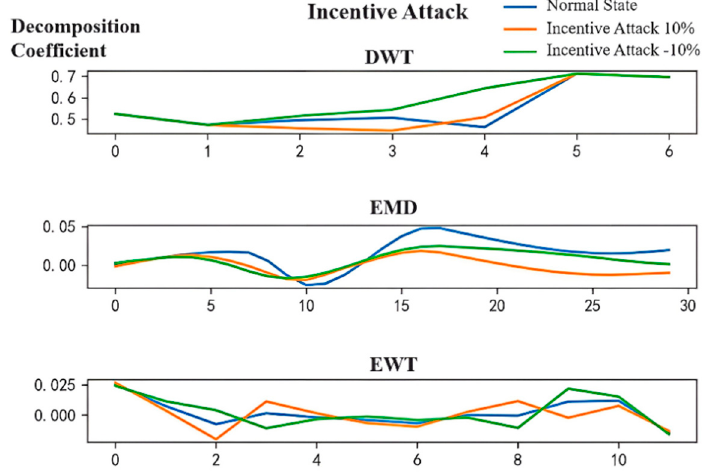
Figure 6. Decomposition coefficients of time-frequency transform under an incentive attack.